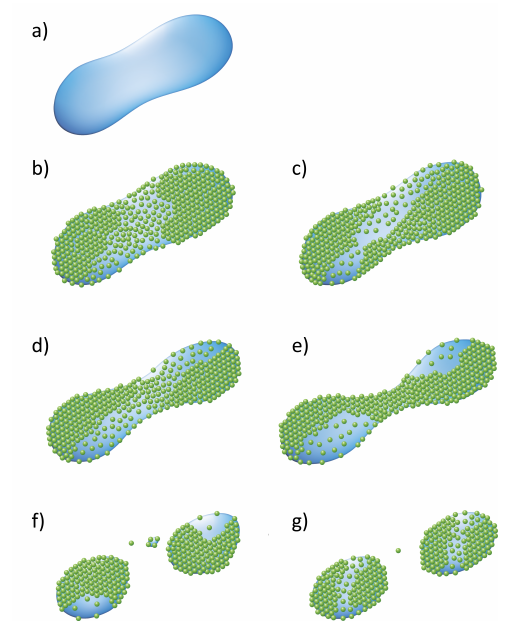
Figure 6. Oil droplet breakup in the presence of nanoparticles: the droplet without particles in a steady state condition ( a ); and snapshots of the droplet covered with particles at different times until the breakup ( b to g ). Figure adapted from Ref. [76].